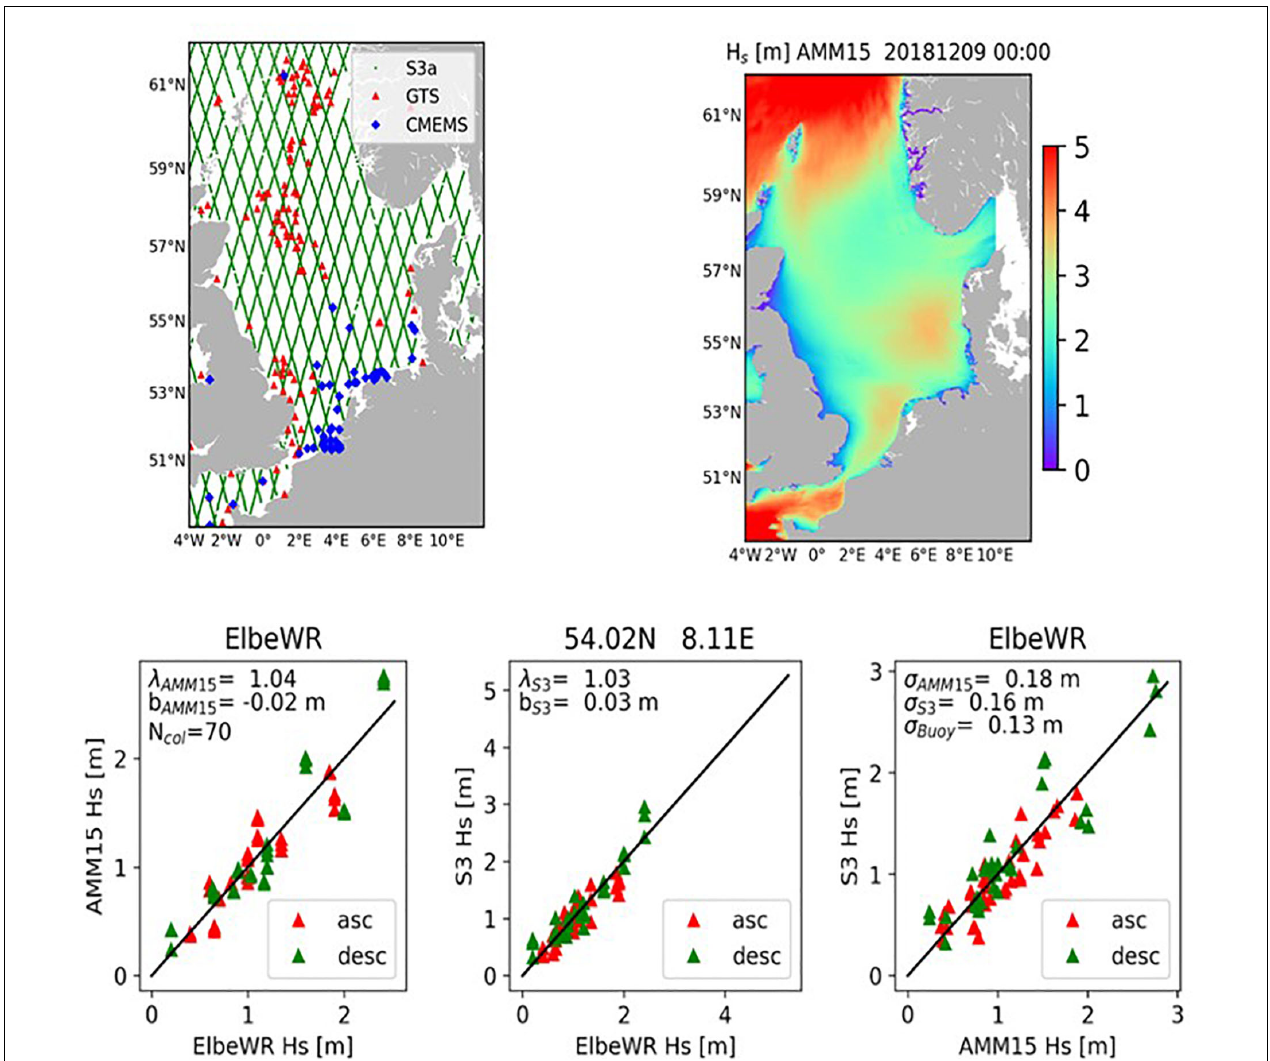
FIGURE 15 | Sentinel-3a tracks together with positions (top left) of CMEMS in-situ wave measurement stations (blue diamonds) and additional GTS wave stations (red triangles), together with an example (top right) of CMEMS AMM17 model H S values for the North Sea pilot case on 10th December, 2018 00:00 UTC. The three bottom panels show a comparison of H S (significant wave height) measured by the Elbe buoy with numerical model results (bottom left) , and Sentinel-3A altimeter measurements (bottom centre) for 2018. After correcting model and satellite data with the calibration factors and bias parameters estimated in the triple collocation procedure, the comparison between Sentinel 3 and modeled data shows (bottom right) limited differences for ascending (asc)and descending (desc) satellite passes, represented by red (asc) and green triangles (desc),